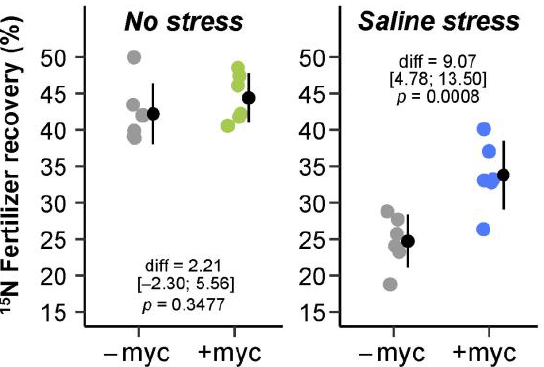
Figure 6. 15 N fertilizer recovery (%) of durum wheat to varying treatments: no-stress or saline stress condition; absence or presence of arbuscular mycorrhizal fungal inoculum ( − myc, +myc). Black circles represent means, with whiskers representing ± SE ( n = 6). Differences (diff) between +myc and − myc means within the same saline treatment, estimated 95% confidence intervals of mean difference (in brackets), and p values are reported inside the plots.